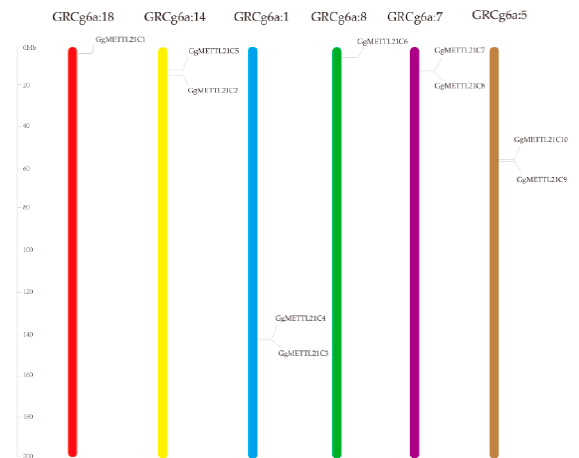
Figure 2. Chromosomal location in chickens of METTL21C genes on six chromosomes. Chromosomal locations in G . gallus are at the top of each bar. The scale of the chromosome is millions of base pairs (Mb).